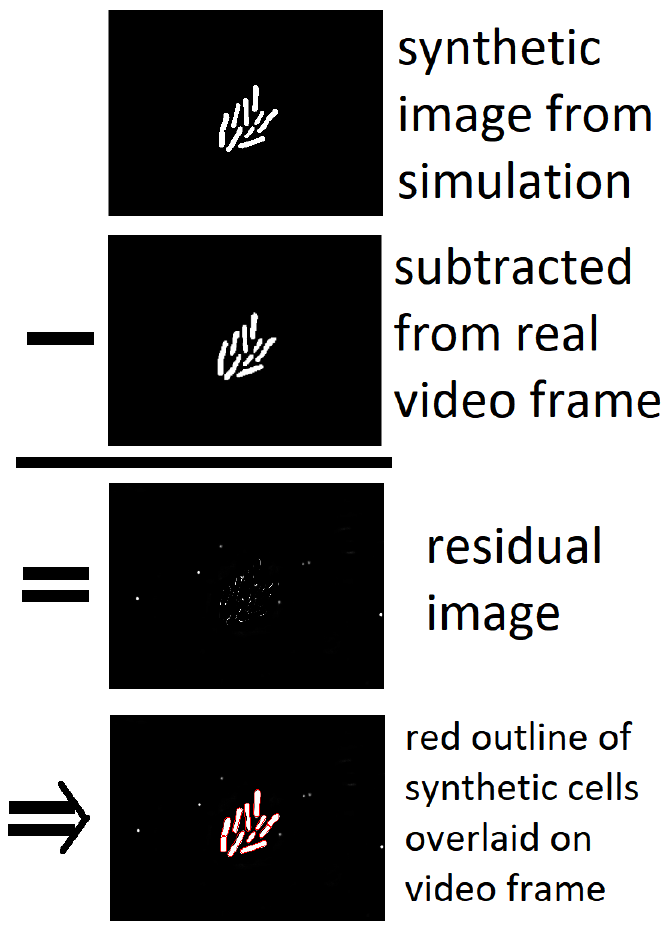
Figure 1. Fitting a synthetic image to the corresponding video frame. We use Frame 26 (cf. Figure 2). ( Top ) synthetic image derived from the positions, sizes, and orientations of the bacteria in one of the many stochastically simulated “universes”at the time of Frame 26, drawn as a binary image of equal dimensions to the real video image. ( Second image ) the “clean” image of Figure 2. ( Residual image ) the pixel-by-pixel difference, in absolute value, between the real and synthetic images; black is zero difference. ( Bottom ) the outline, drawn in red, of the synthetic bacteria of the top image, overlaid on top of the “clean” video frame of Figure